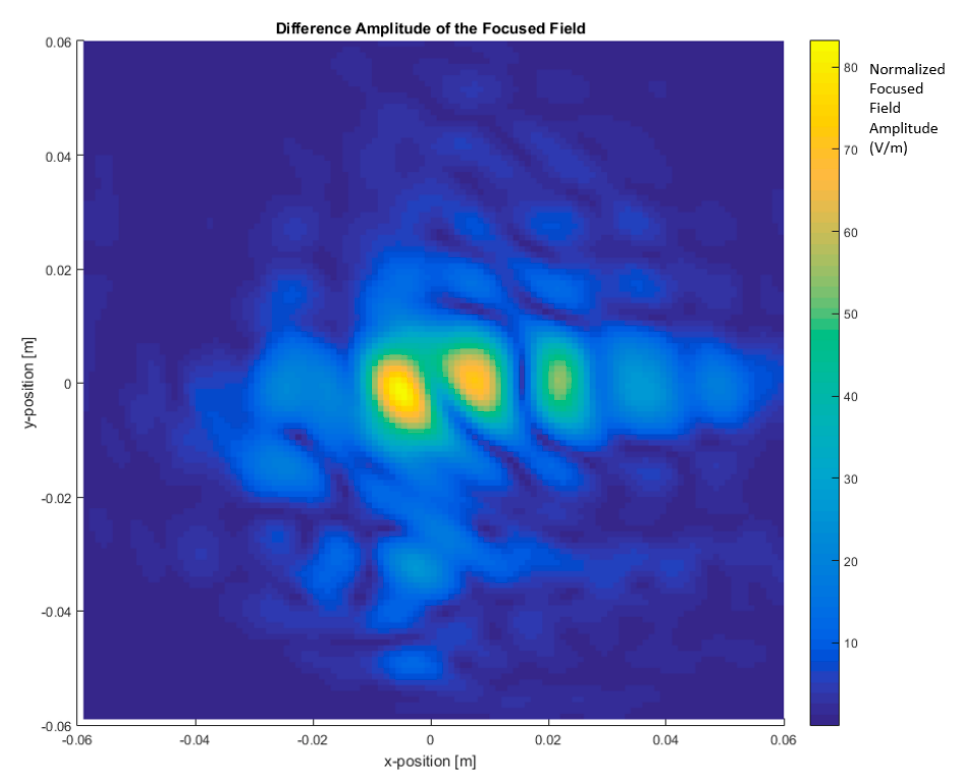
Figure 8. Differential focused field amplitude between the metallic car with and without an antenna. Frequency range: 220 GHz to 330 GHz (BW = 110 GHz).